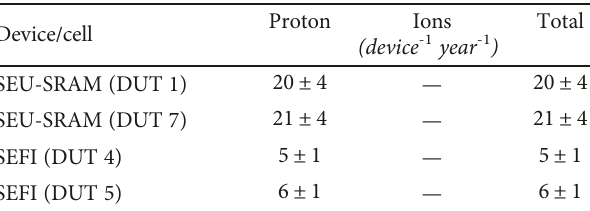
Table 4: SEU and SEFI rates for CoolRunner-II. Device/cell